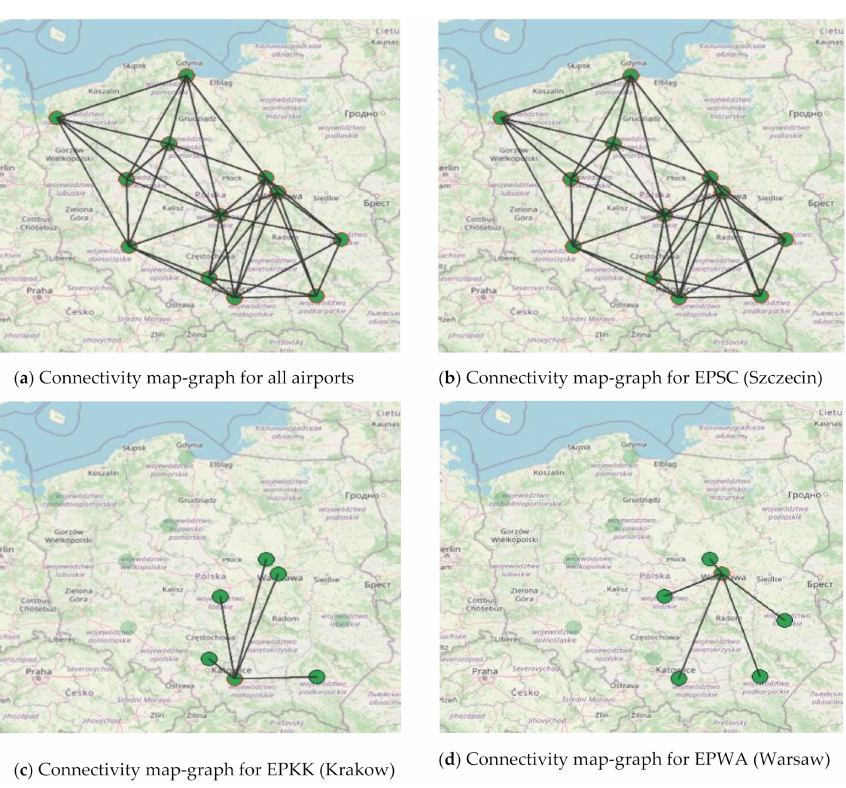
Figure 3. Connectivity map-graphs for airports. Source: own elaboration based on data from Tables 1 and 4. Basemap from © OpenStreetMap contributors 2021 [44]. Distributed under a CC BY-SA